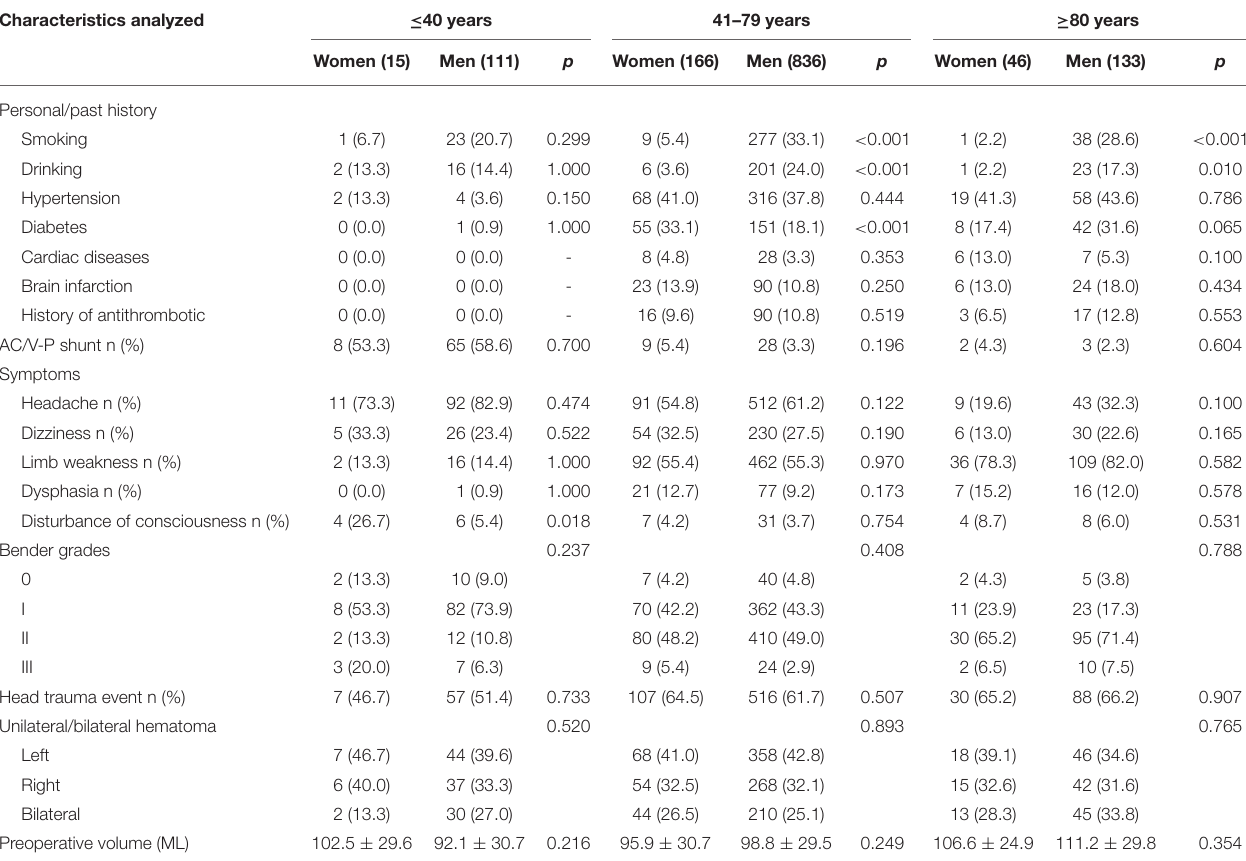
TABLE 2 | Relationship between clinical characteristics and groups of gender in different age patients with chronic subdural hematoma. Characteristics